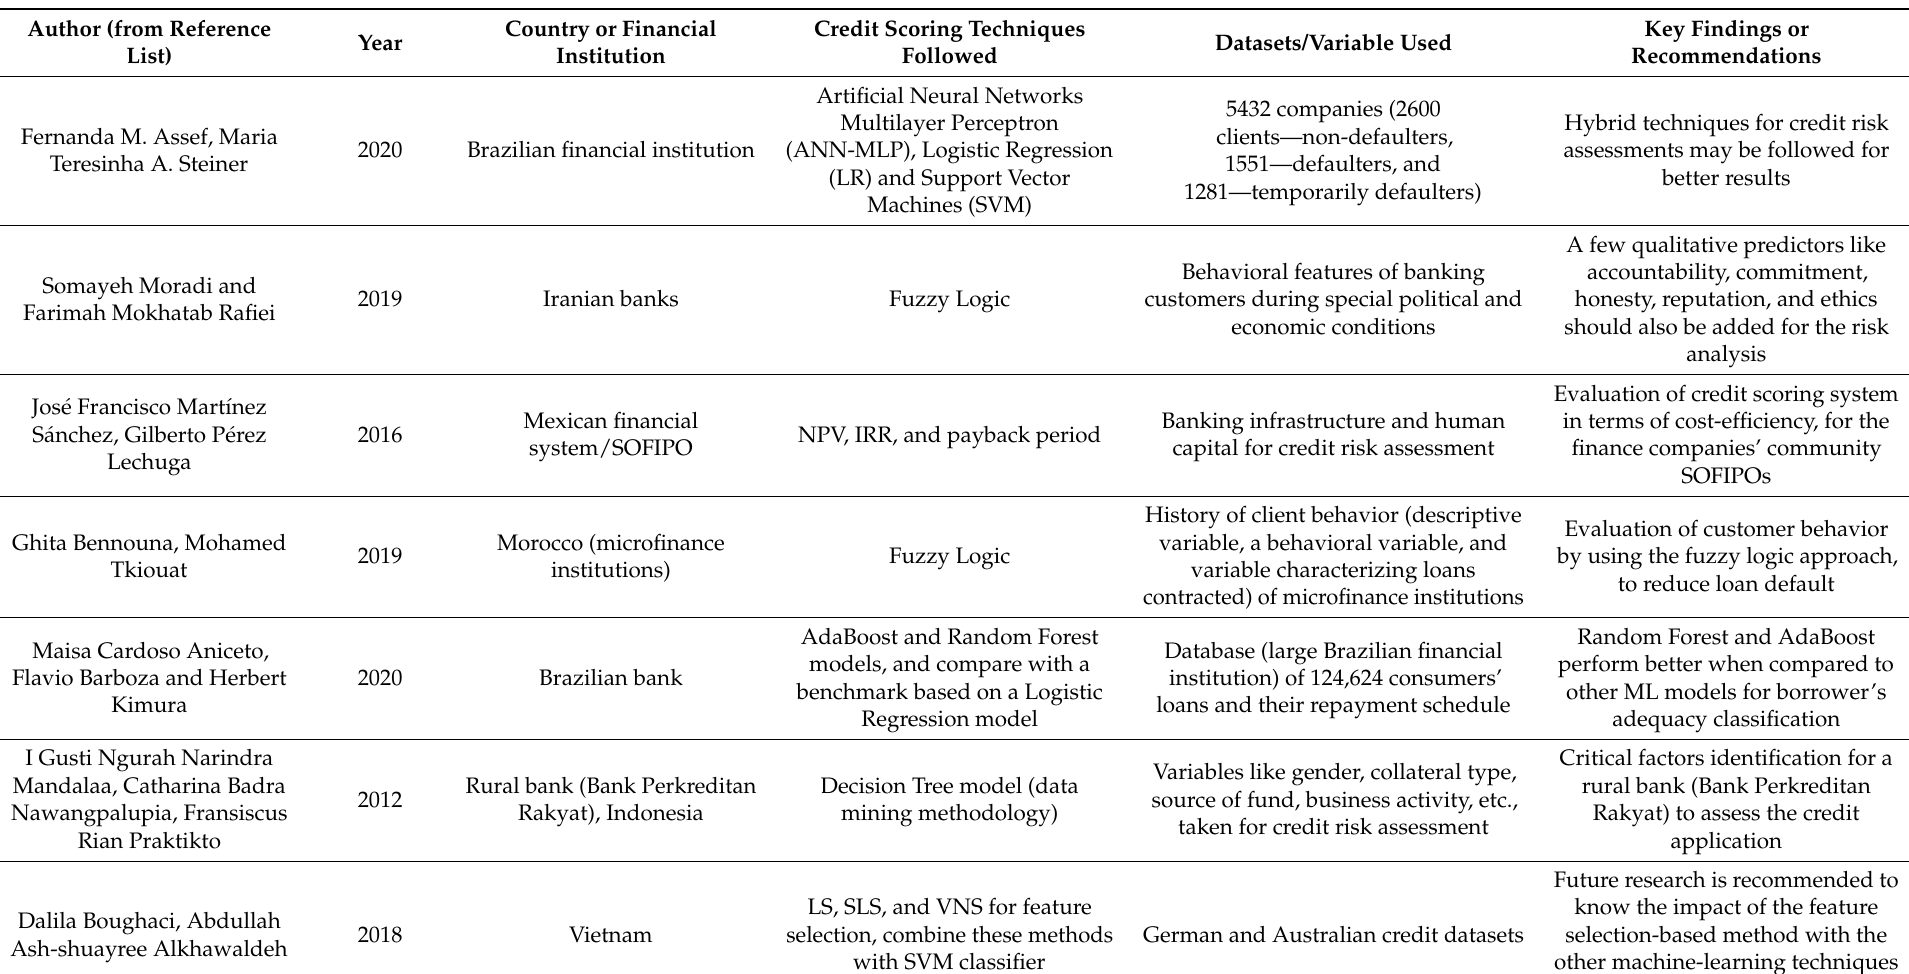
Table 1. Key findings drawn from the empirical studies of the reviewed works of literature in this